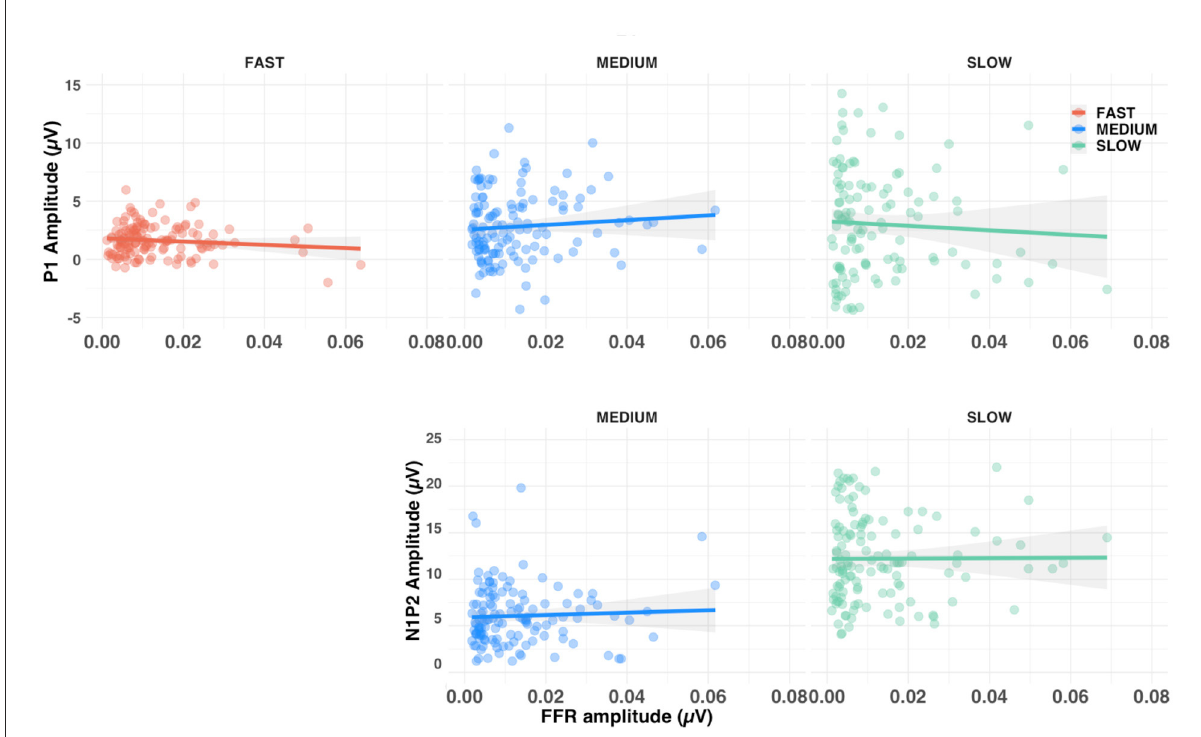
FIGURE8 Scatterplots of the relationship between FFR amplitude and both P1 amplitude (upper row) and N1-P2 amplitude difference (lower row). Shaded lines represent the 95% confidence interval around the linear regression. Note that the fast-alternating rate did not allow enough time to elicit an N1-P2, which are not